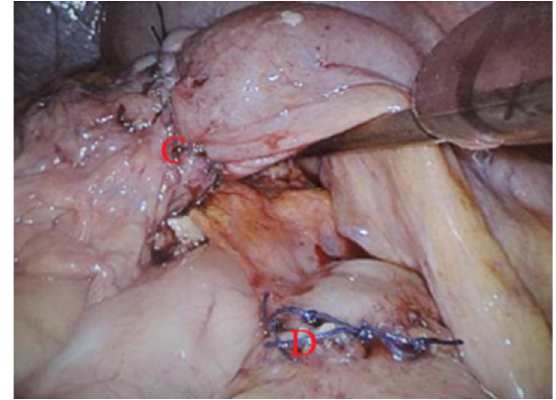
Fig. 2 Image during the laparascopy in December 2018 after repairing the defect in the gastrojejunal anastomosis ( C ) and and after repairing the defect in the transverse colon ( D